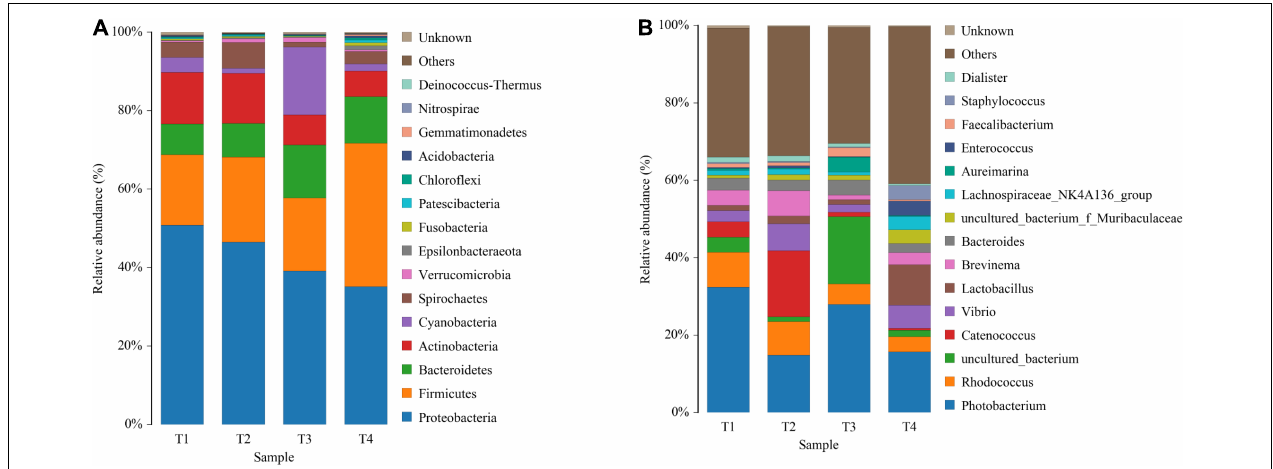
FIGURE 5 | Composition and relative abundance of bacterial communities based on 16S rRNA gene sequences on day 56. Panels (A,B) indicate the composition and relative abundance of microbial communities at phylum and genus level,